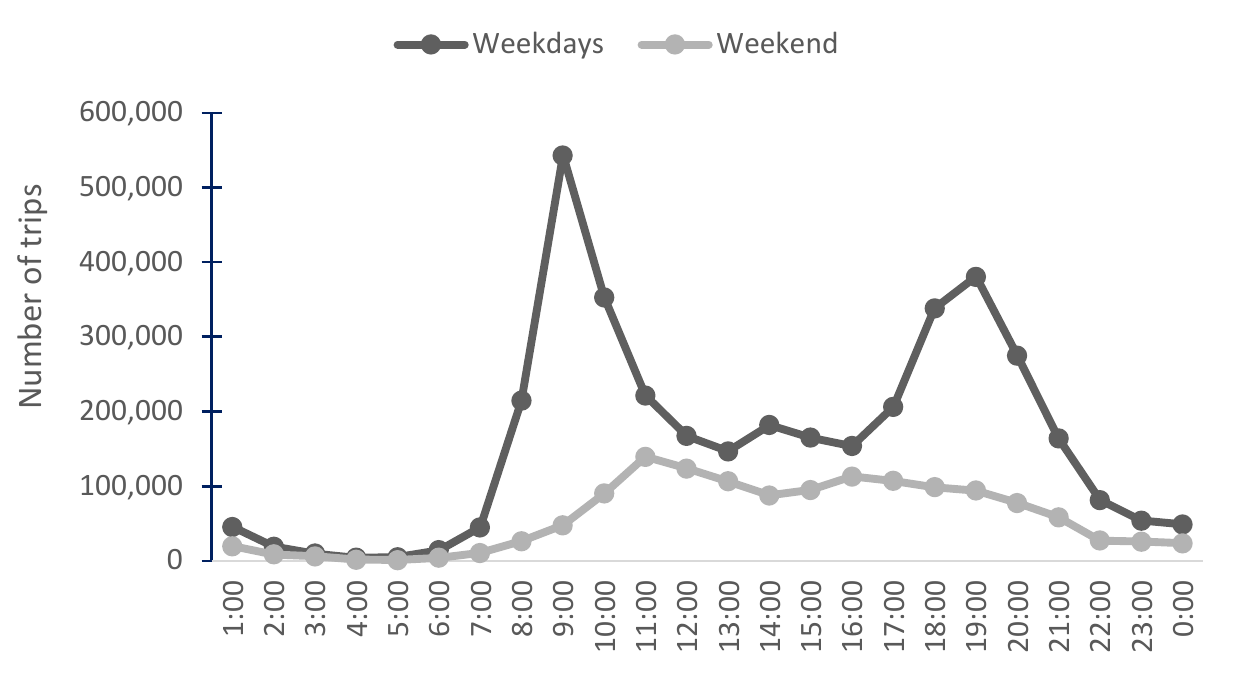
Figure 4. Rush hours in daily movements (average number of trips) of people within Lisbon Metropolitan area as of 2017 [15].